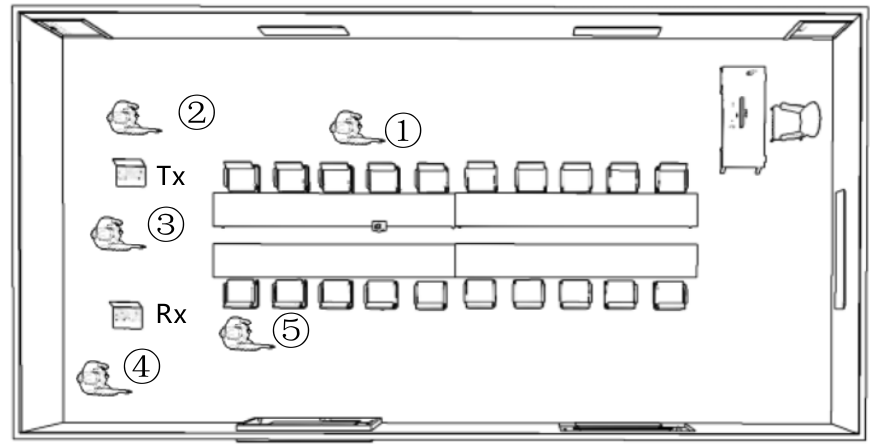
Figure 14. Experimental position design. The numbers in the diagram represent the position of the personnel.